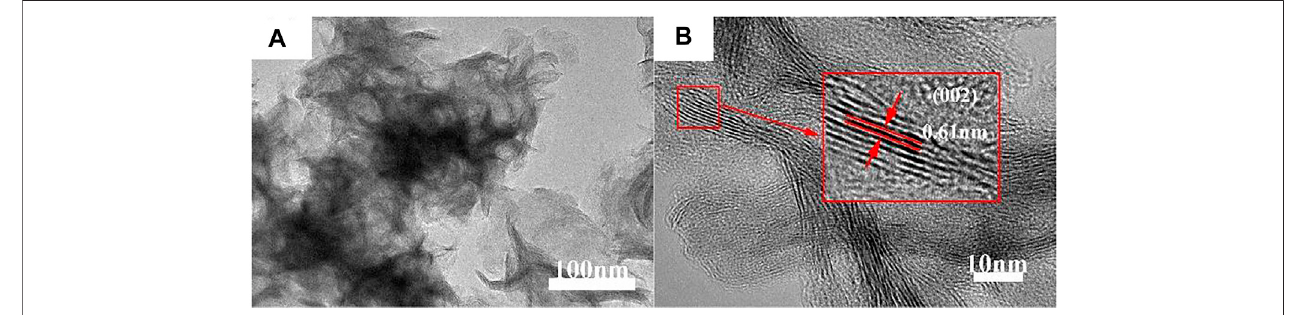
FIGURE 3 | (A) TEM and (B) HRTEM images of MoS 2 /C composites prepared by the hydrothermal calcination method with the concentrations of molybdenum chloride of 0.20 mol/L.